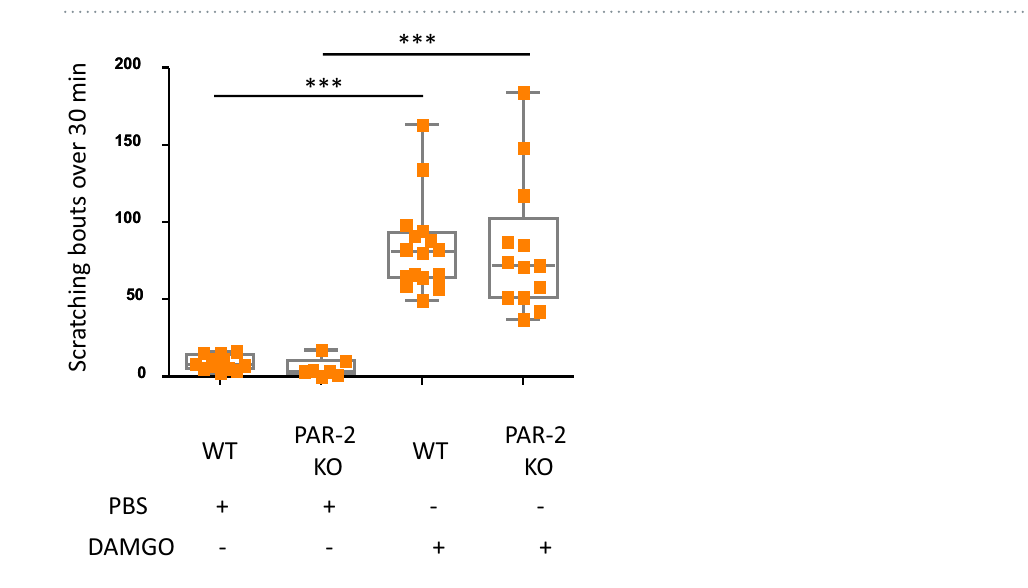
Figure 2. DAMGO induces itch in mast cell-deficient mice. Scratching bouts evoked by intradermal injections of either PBS or DAMGO (200 µ M) in WT (PBS; n = 12, DAMGO; n = 13) and mast cell-knockout (KO) mice (PBS; n = 14, DAMGO; n = 16). Results are represented as Whisker-dot plot (Min-Mean-Max) and each symbol represents an individual mouse. Statistical analysis were performed using Kruskall-Wallis followed by post-hoc Dunn’s test ( *** p < 0.001 WT + DAMGO versus WT + PBS and ** p < 0.01 represents mast cell KO + PBS versus mast cell KO + DAMGO).